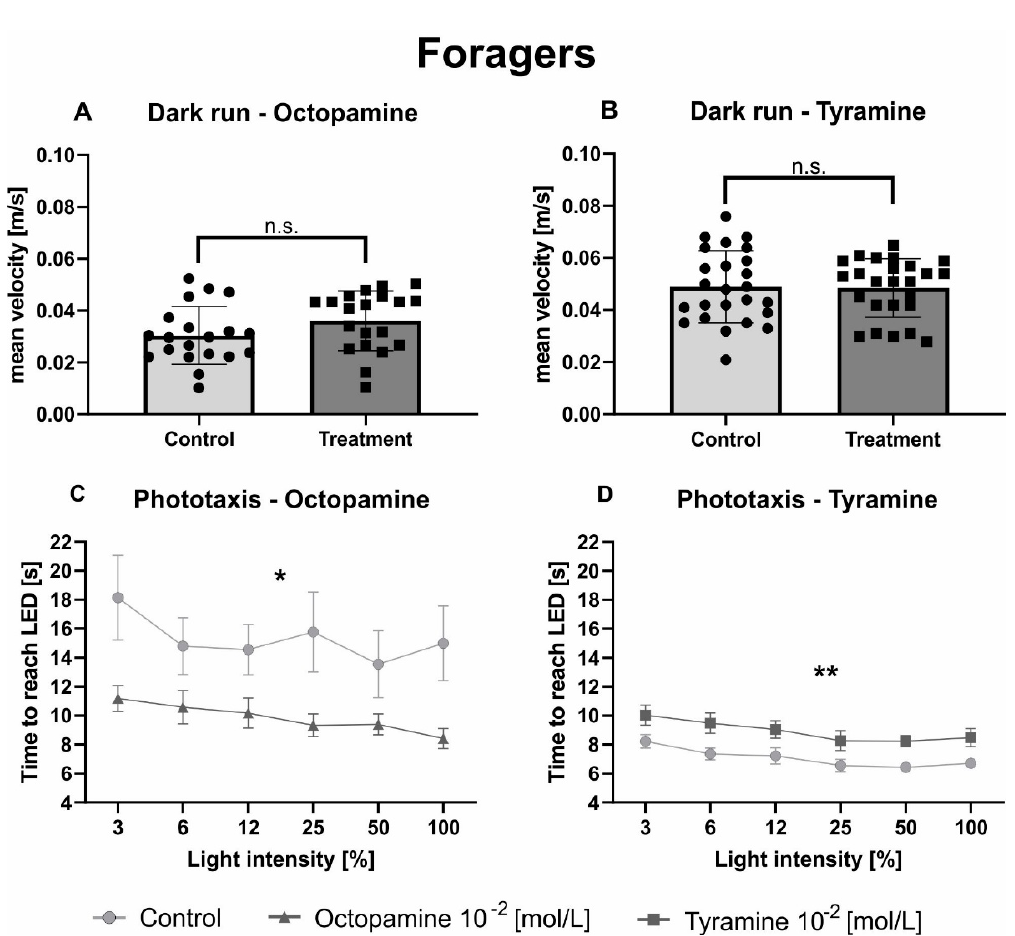
Figure 3. Octopamine and tyramine have opposite effects on the phototaxis of foragers. Control bees are shown in light grey. Those injected with OA (10 − 2 mol/L) or TA (10 − 2 mol/L) are shown in dark grey. ( A , B ): Average velocity (mean + standard deviation) of honeybees during one minute of constant movement in the dark arena. Neither OA nor TA did differ significantly from Ringer in their mean velocity in the dark (Table 3). ( C , D ): Average walking time (mean + standard error) towards the different switched-on light sources. The light intensity factor significantly influenced phototacic behavior (Table 3). Octopamine decreased the time honeybees needed to reach the switched-on LEDs significantly compared to the control solution, while TA increased it (Table 3). Significant differences between Ringer and OA/TA are indicated by asterisks (n.s. p > 0.05, * p < 0.05, ** p < 0.01). Table 3. Statistical comparison of the dark runs and the phototaxis of honeybees (either in-hive bees or foragers) treated with octopamine/tyramine (treatment) or Ringer (control). Octopamine (In- Unpaired t Hive) Test